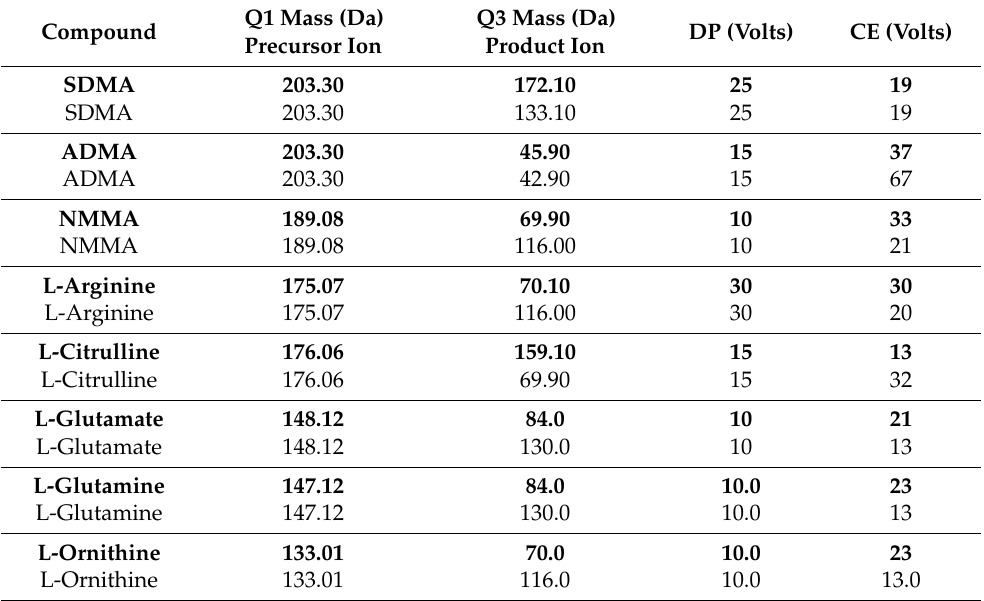
Table 1. Mass spectrometric parameters for multiple reaction monitoring. Prime transition ions in